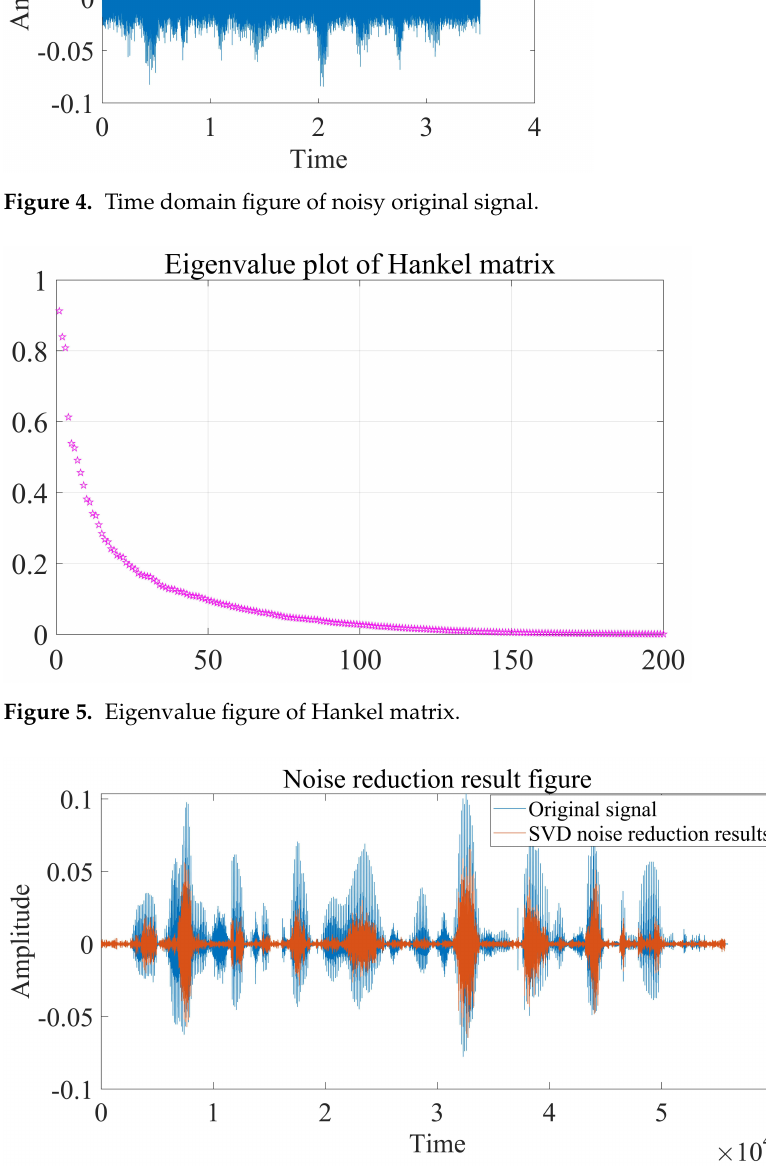
Figure 6. Comparison of SVD noise reduction results and original